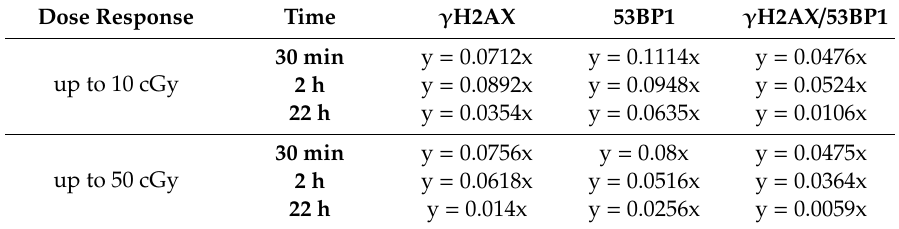
Table 3. Slope of linear response (either up to dose of 10 cGy or up to 50 cGy) for γ H2AX, 53BP1, and co-localized γ H2AX / 53BP1 as measured at di ff erent post irradiation